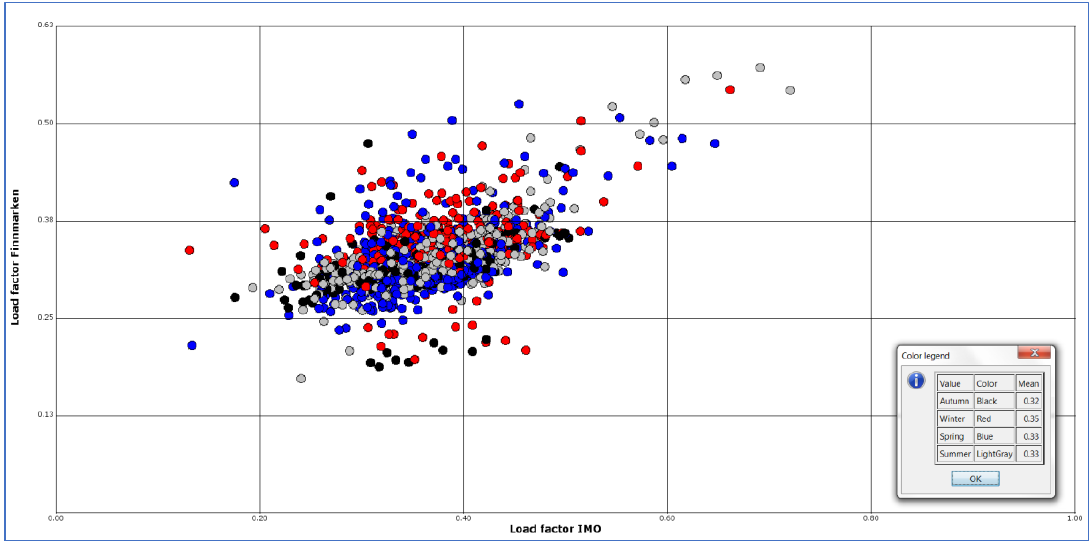
Figure 8. Estimated load factors (actual power over installed power) versus Real-World Load Factors for Finnmarken.